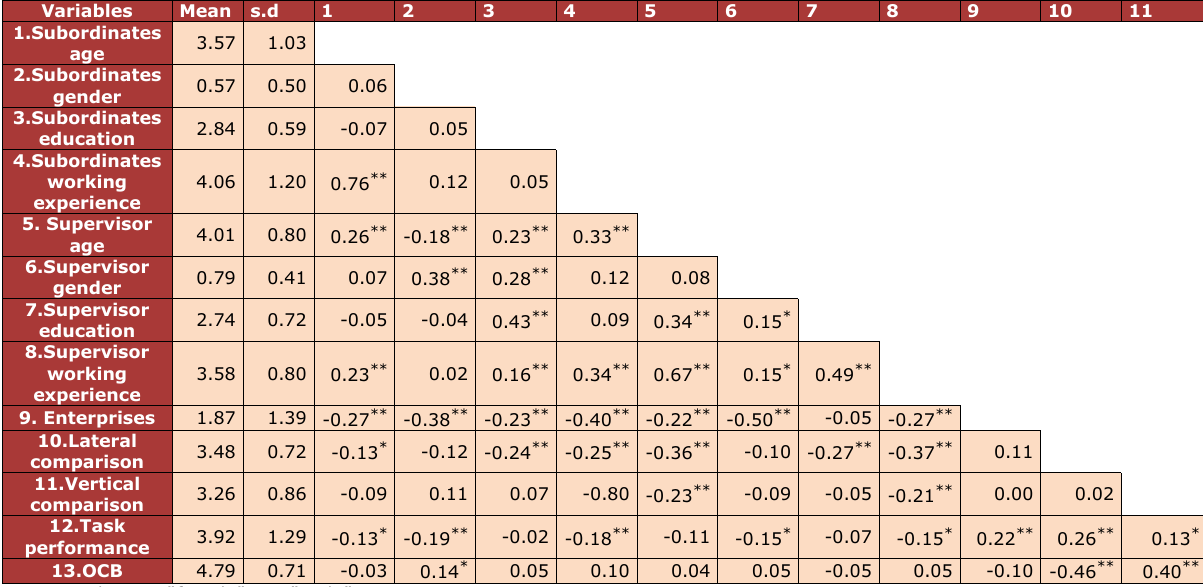
Table 2. Mean, standard deviations, and correlations of the